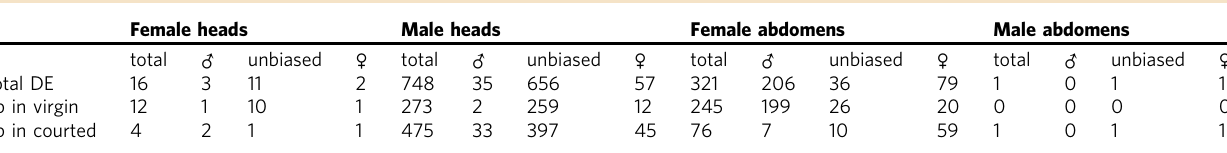
Table 2 Number of genes which are differentially expressed (FDR 10%) as a result of courtship experience in fl ies from the Baseline population, and their sex-bias status